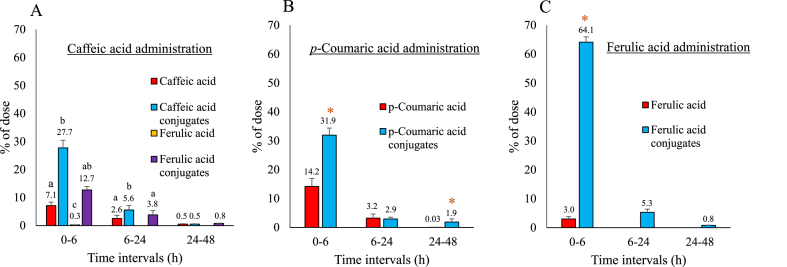
The urinary excretion rate (% of the dose) of caffeic acid (A), p-coumaric acid (B), and ferulic acid (C) after oral administration to non-fasted rats. The data represent the mean ± SE (n = 4). Forty mg/kg BW of caffeic acid, p-coumaric acid, or ferulic acid was gavaged to the non-fasted rats. The rats were fed the AIN-93M diet throughout the experiment. The urine was collected at time intervals of 0–6 h, 6–24 h, and 24–48 h after HA administration. The numbers above the bars comprise the mean values. A single asterisk (*) and different letters indicate statistically significant differences (P < 0.05).